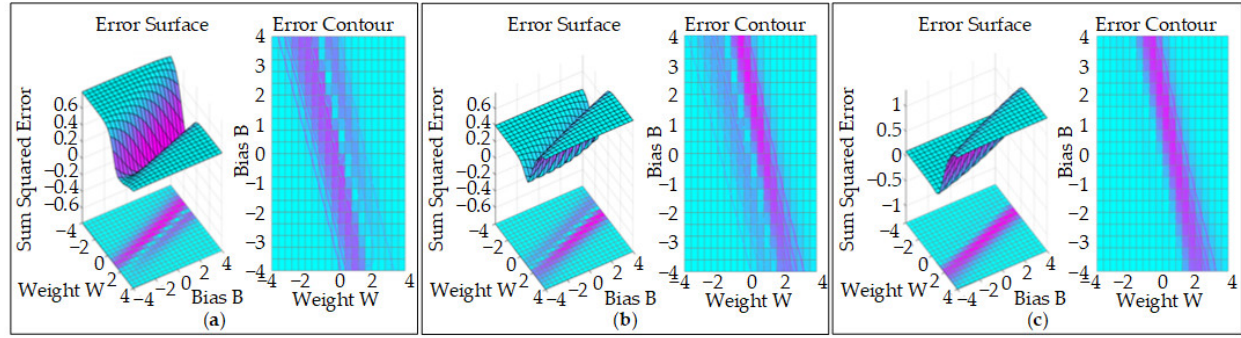
Figure 6. The error surface of neural network prediction models: ( a ) BP model; ( b ) SOM-RBF model; ( c ) RLSOM-RBF model.